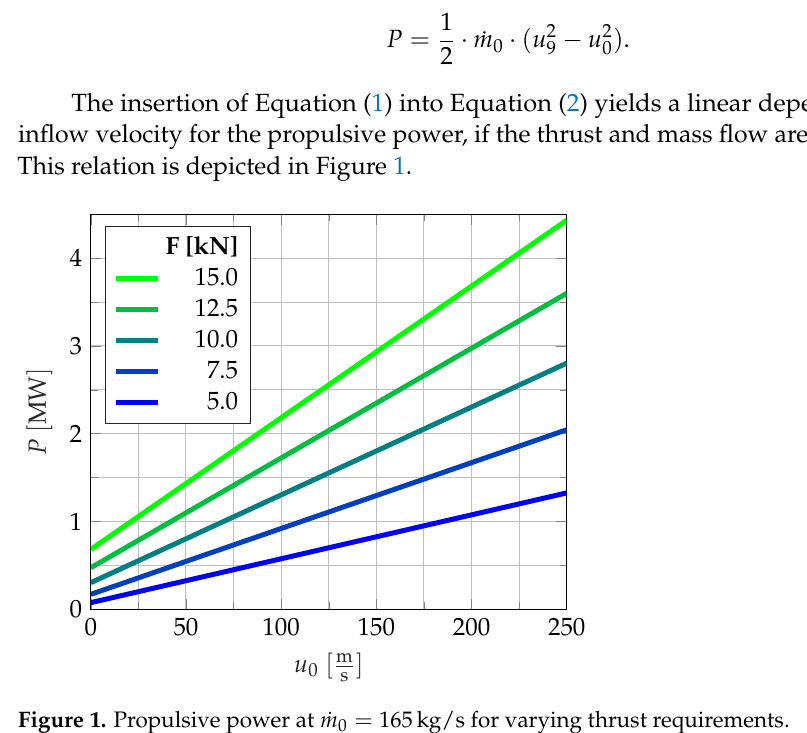
Figure 1. Propulsive power at ˙ m 0 = 165kg/s for varying thrust